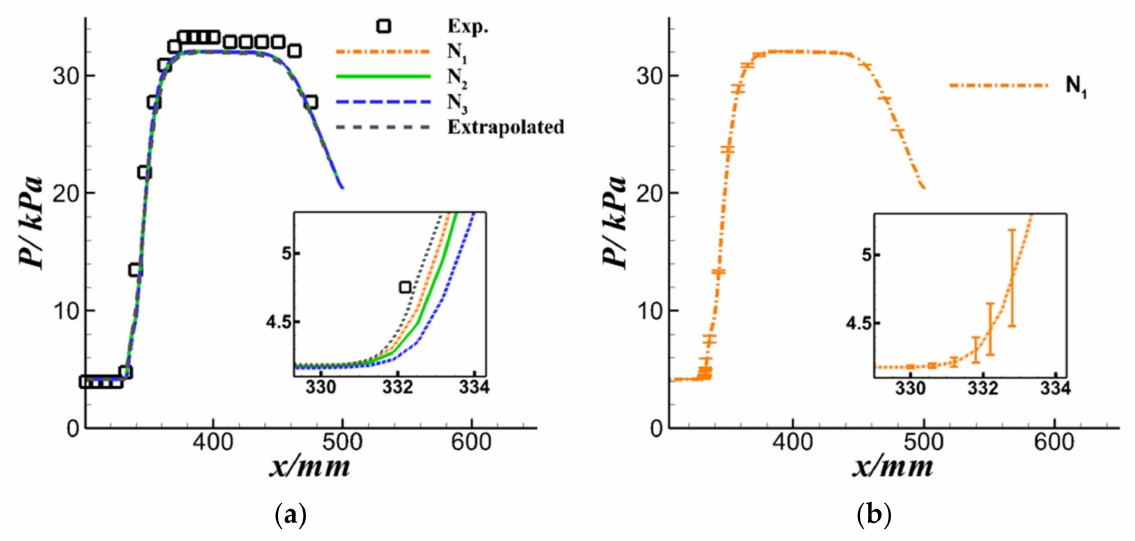
Figure 3. ( a ) Wall pressure distributions along the center line on the flat plate; ( b ) N 1 solution, with discretization error bar GCI 21